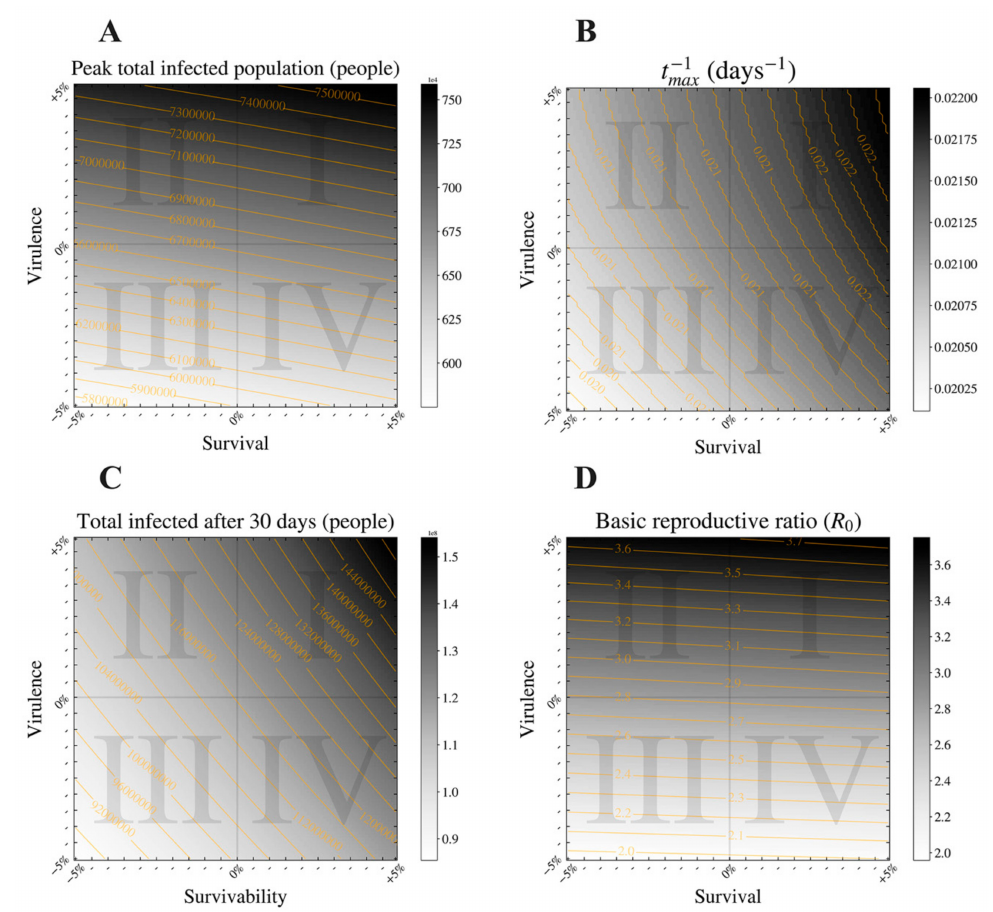
Figure 4. Heatmap describing the impact of varying virus virulence and survival trait values assessed across four key epidemic metrics: these heatmaps express the change in ( A ) the number of infected individuals (asymptomatic and symptomatic) at the epidemic peak; ( B ) the rate at which the epidemic peak is reached, t max − 1 ; ( C ) the total infected population after 30 days; and ( D ) the basic reproductive ratio ( R 0 ) when virulence and survival are modulated by ± 5% within the model. Contour lines are available for